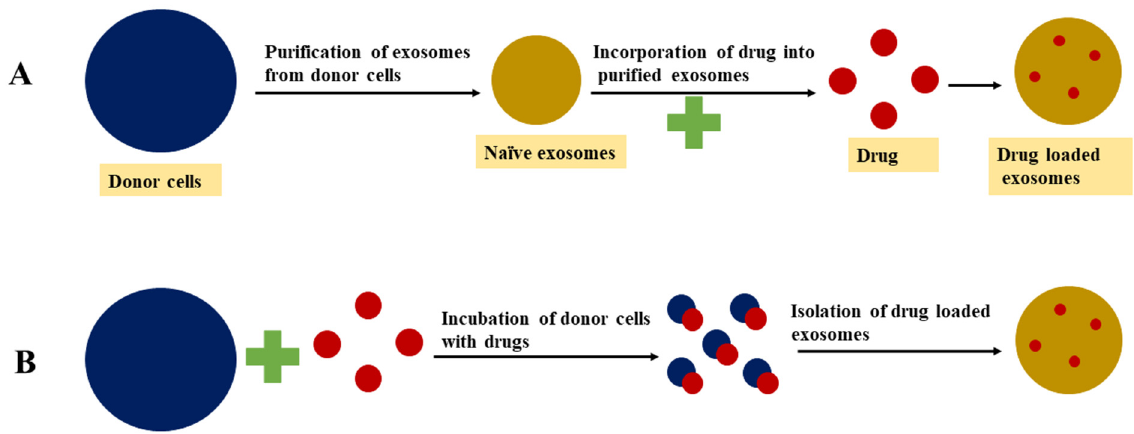
Figure 3. Exosomal drug loading approaches: ( A ) postloading approach; ( B ) preloading approach.